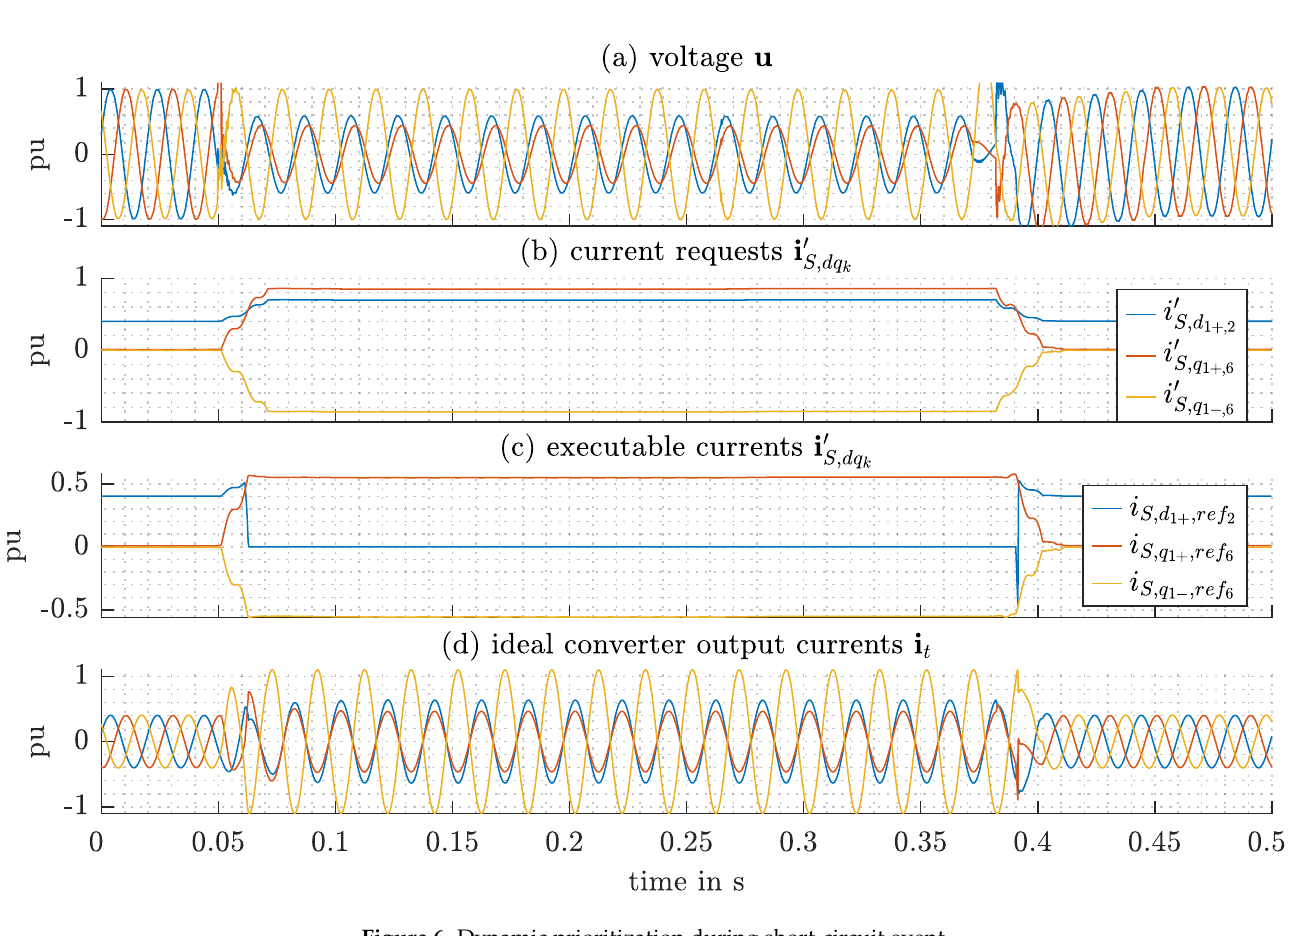
Figure 6. Dynamic prioritization during short-circuit event.